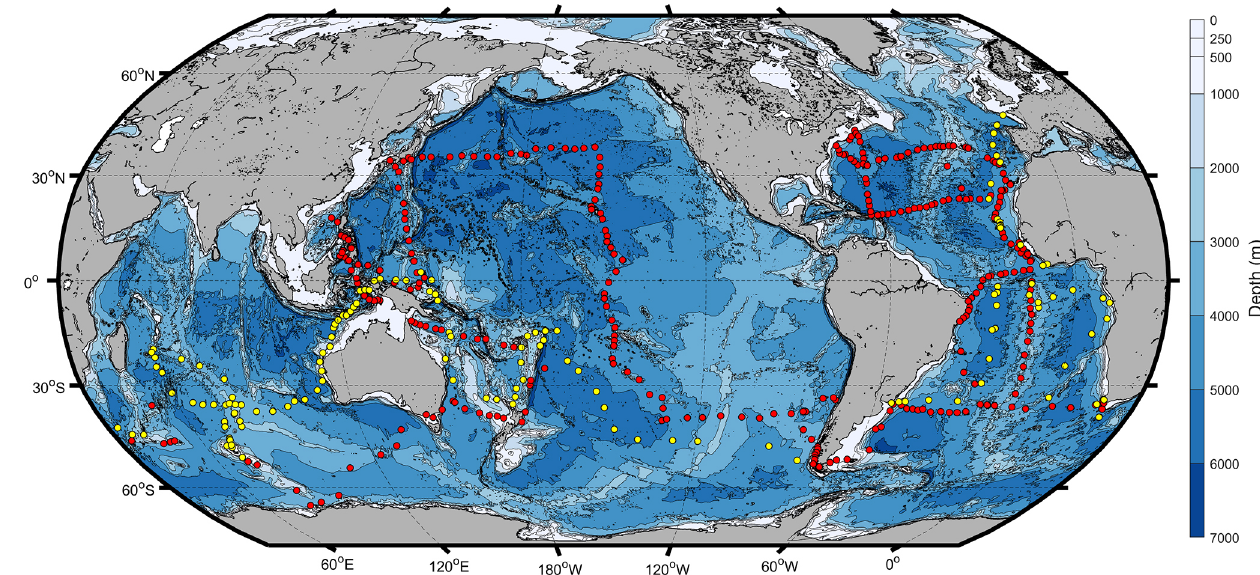
Figure 1. Challenger (red) and Gazelle (yellow) station positions overlaid on the now known (ETOP05) ocean